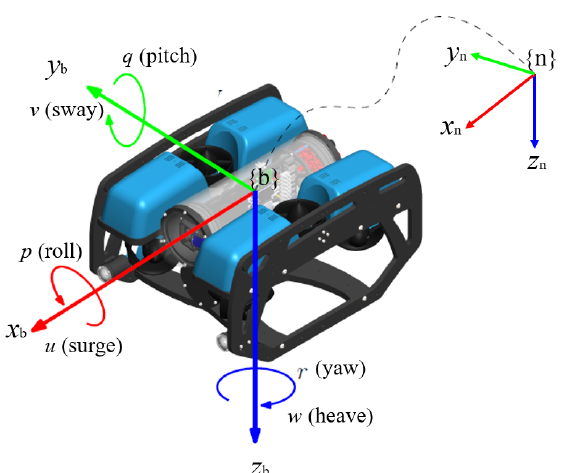
Figure 1. The coordinate system used in the ROV